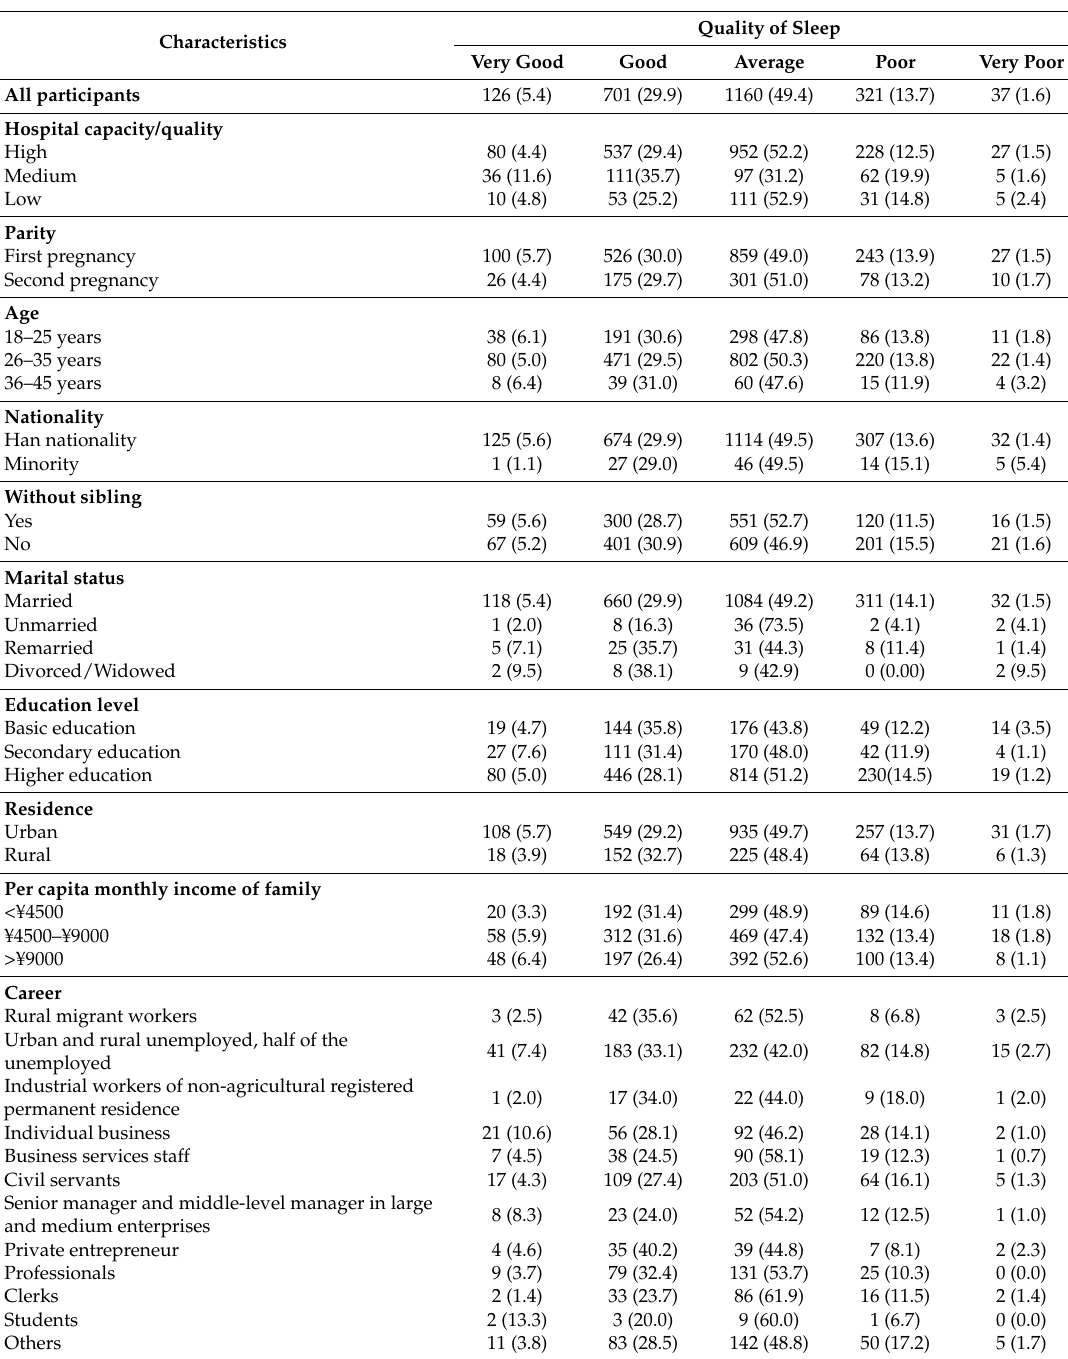
Table 3. Characteristics of study participants as stratified by sleep quality status in 2015 ( n ,